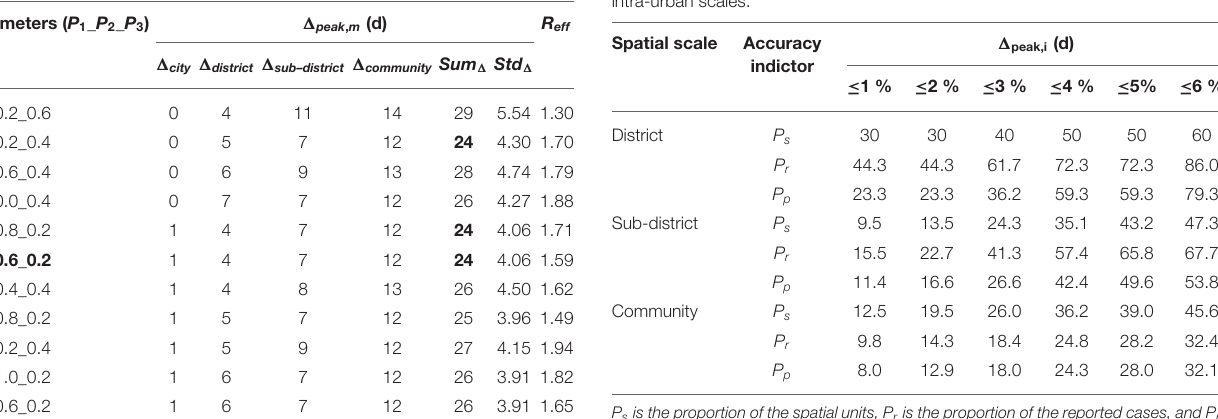
TABLE 3 | Calibration of the unknown model parameters. TABLE 4 | The accuracy of the proposed influenza model at three different